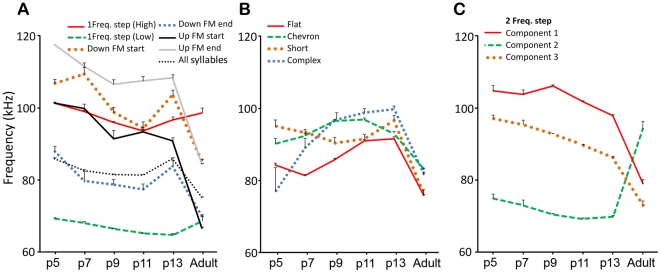
Changes in frequencies for each of several syllables, and for all syllables (dotted black line).(A) Dominant frequencies declined somewhat with pup age. (B) Syllable types that showed an increase in dominant frequency with pup age. In all cases, dominant frequency declined between p13 pups and adults. (C) The dominant frequencies of the three components of the 2 freq. step syllable; the stepped pattern was reversed for adult animals.